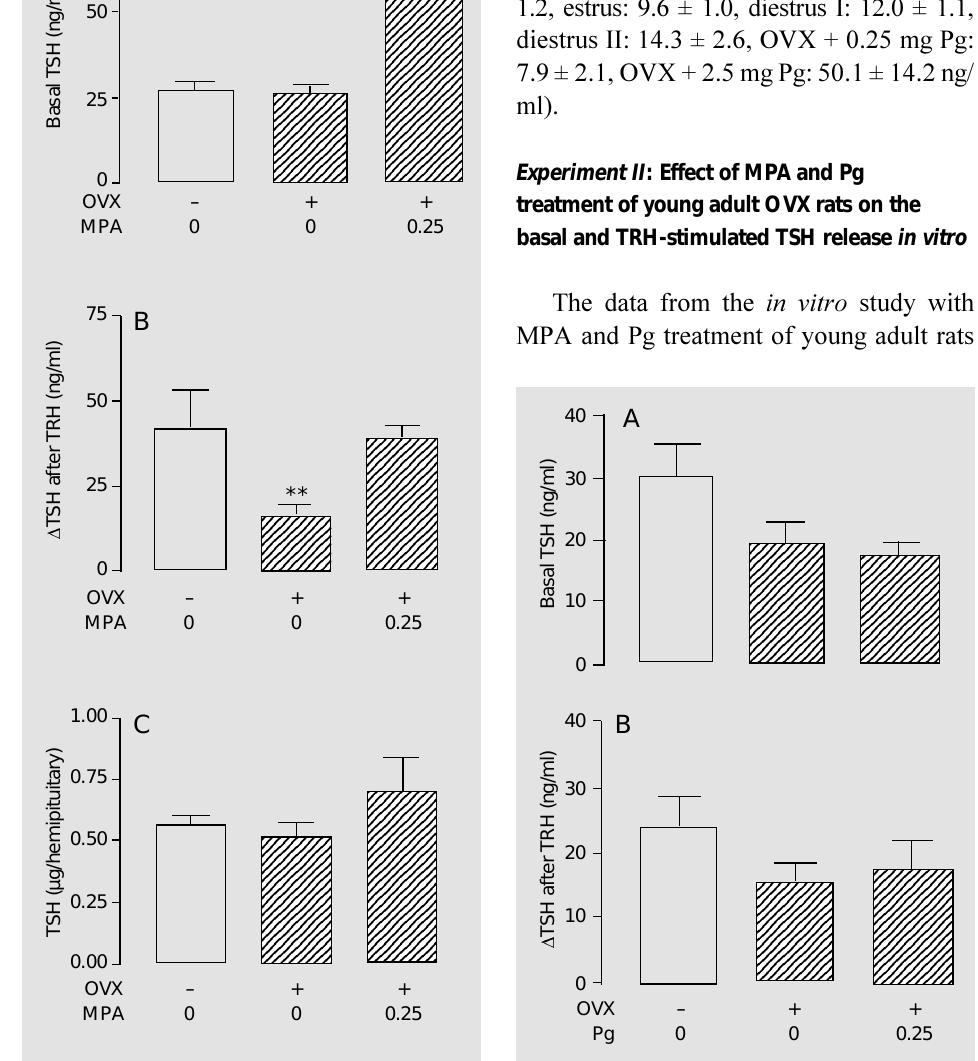
Figure 4 - In vitro basal (panel A) and TRH-stimulated (panel B) TSH release from hemipituitaries of young adult (3 months old) sham-operated or ovariectomized (OVX) rats treated with progesterone (Pg, 0.25 mg/100 g body weight, sc , for 9 days) or saline. Number of hemipituitaries per group: 9-13. D TSH values were cal- culated as the difference between medium TSH and basal TSH after